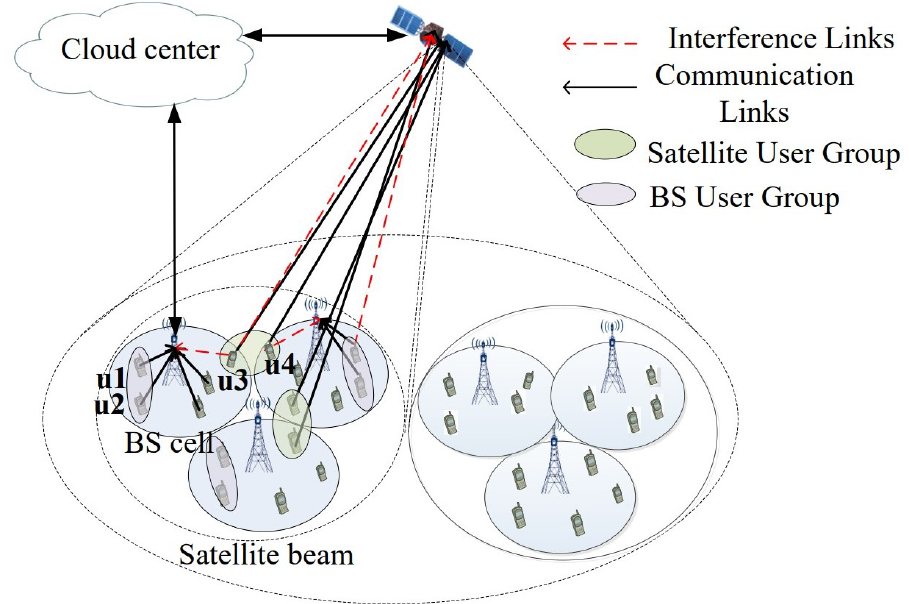
Figure 1. The system model of the non-orthogonal multiple access based integrated terrestrial- satellite